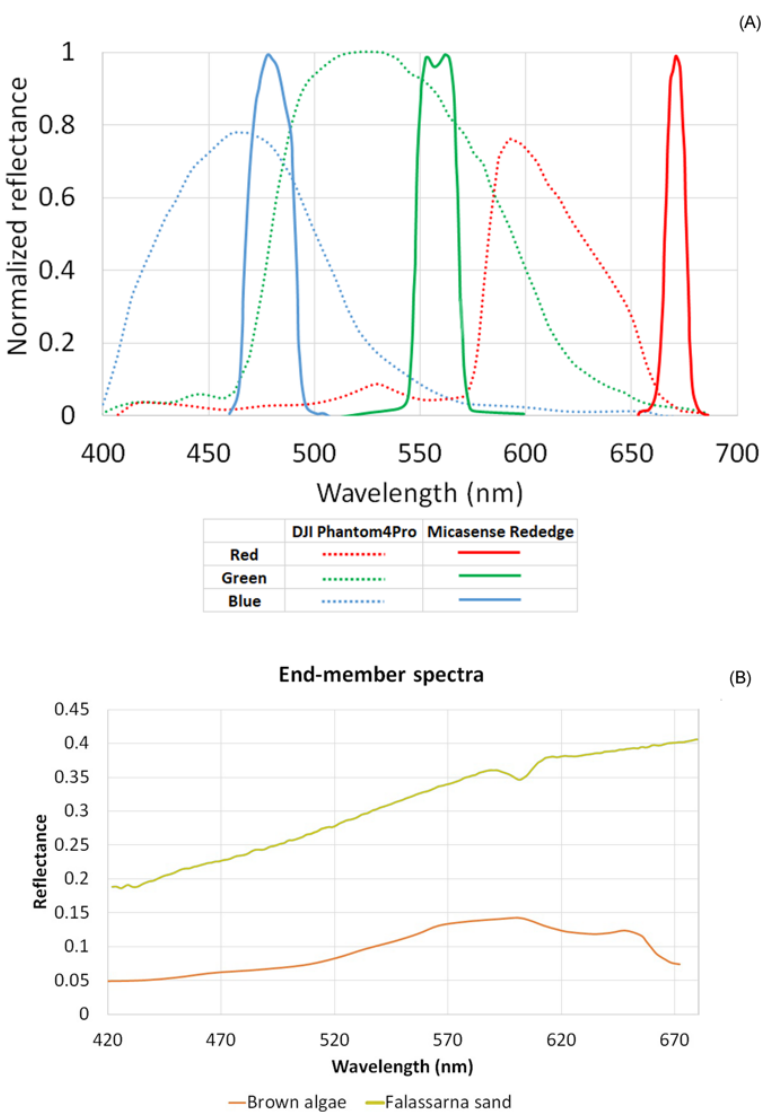
Figure 2. ( A ) Spectral responses of both RGB and MS sensors (Source: [41]); ( B ) Spectral signatures of the two end-member spectra used for bathymetry inversion.